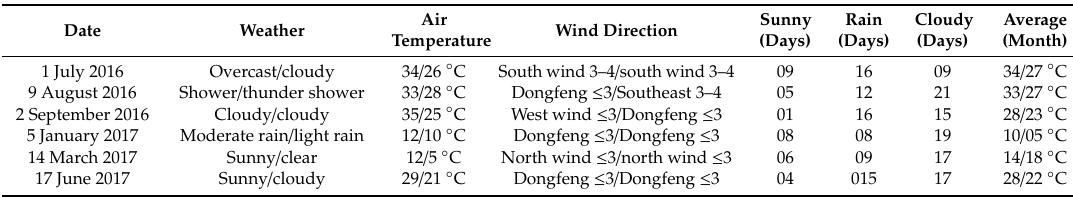
Table 1. Example of a temperature